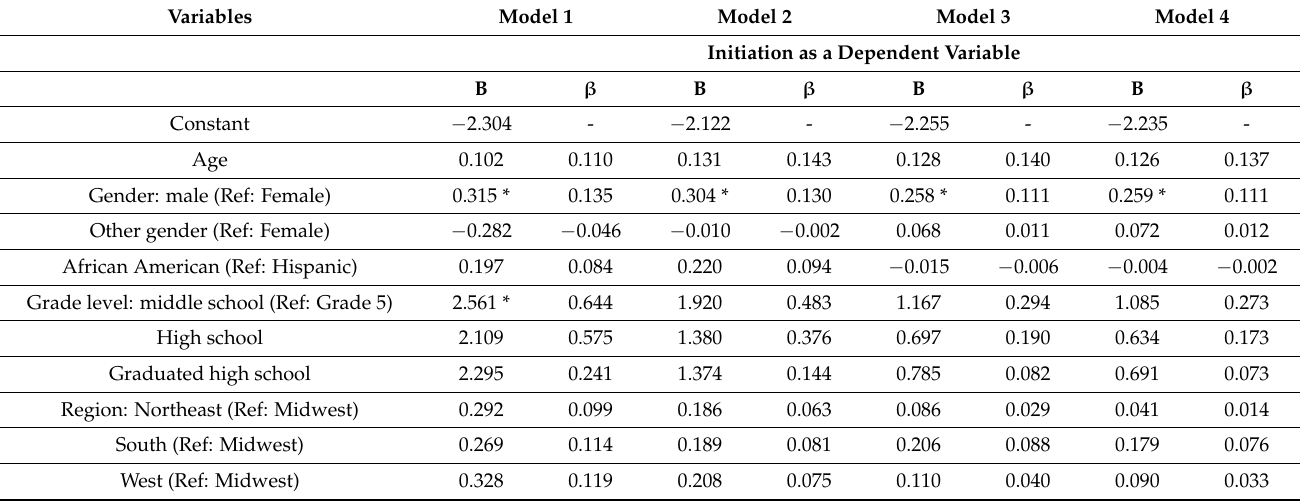
Table 8. Hierarchical multiple regression to predict the likelihood of initiating flossing among participants who were not flossing (N =